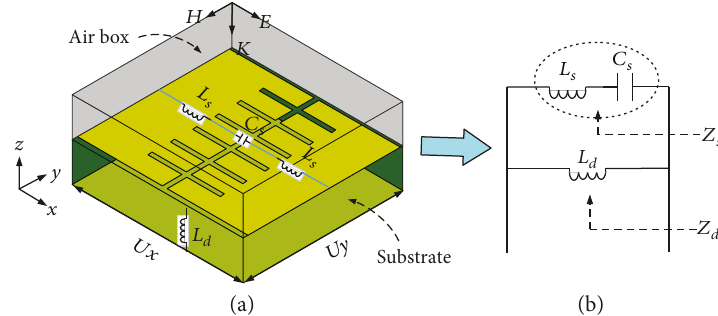
Figure 2: (a) Con fi guration of a PSMS unit cell. (b) E ff ective equivalent circuit model illuminated by incident plane wave in the − z